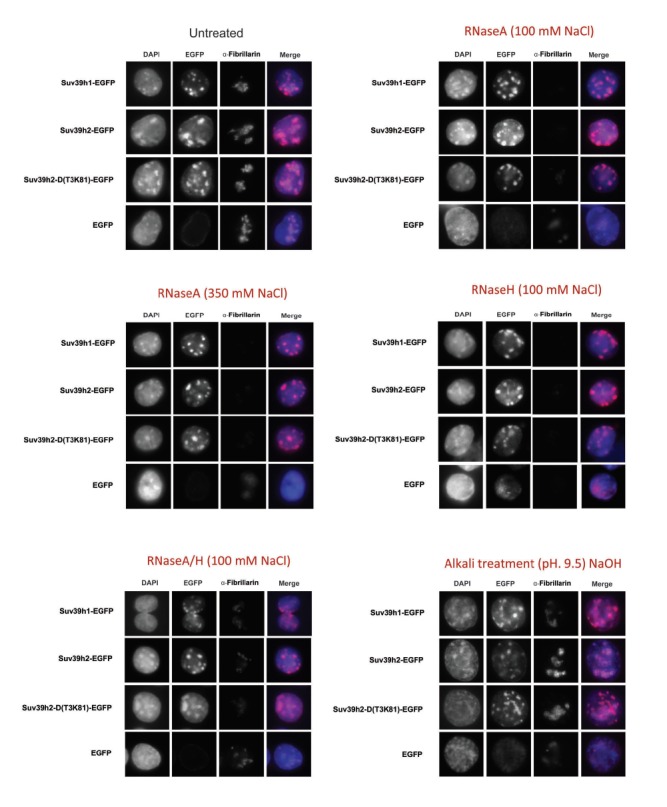
DOI:
http://dx.doi.org/10.7554/eLife.25293.019